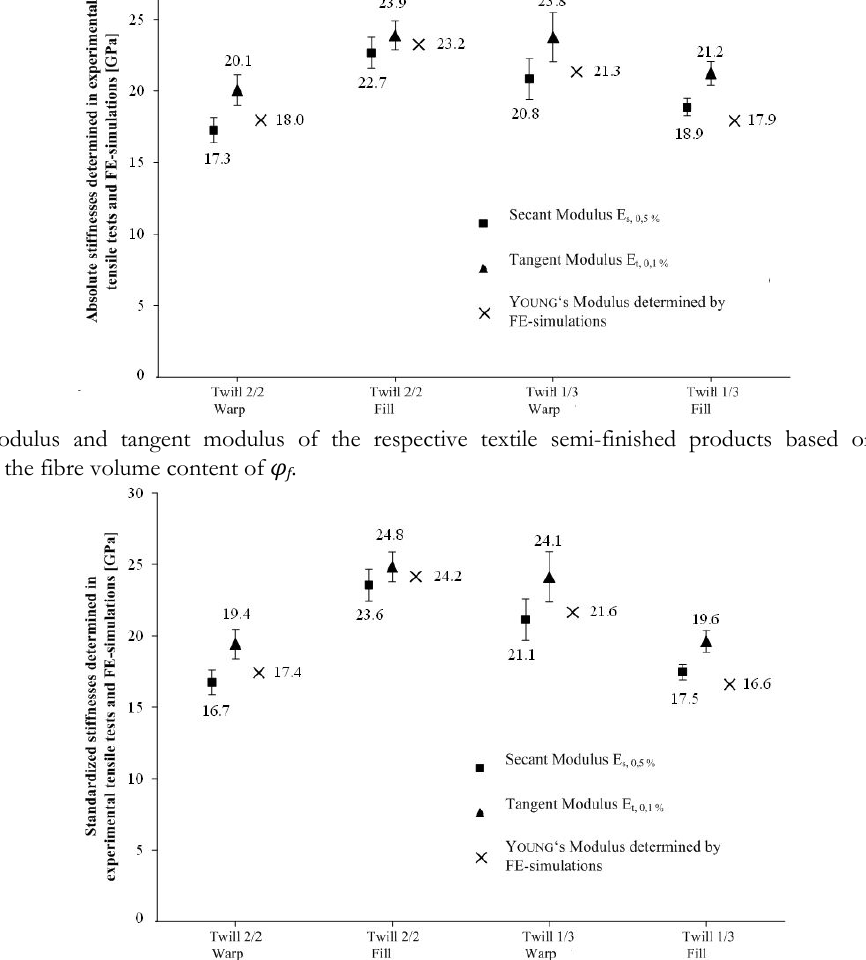
Figure 10: Secant modulus and tangent modulus of the respective textile semi-finished products standardized to a fibre volume content of φ f =50%